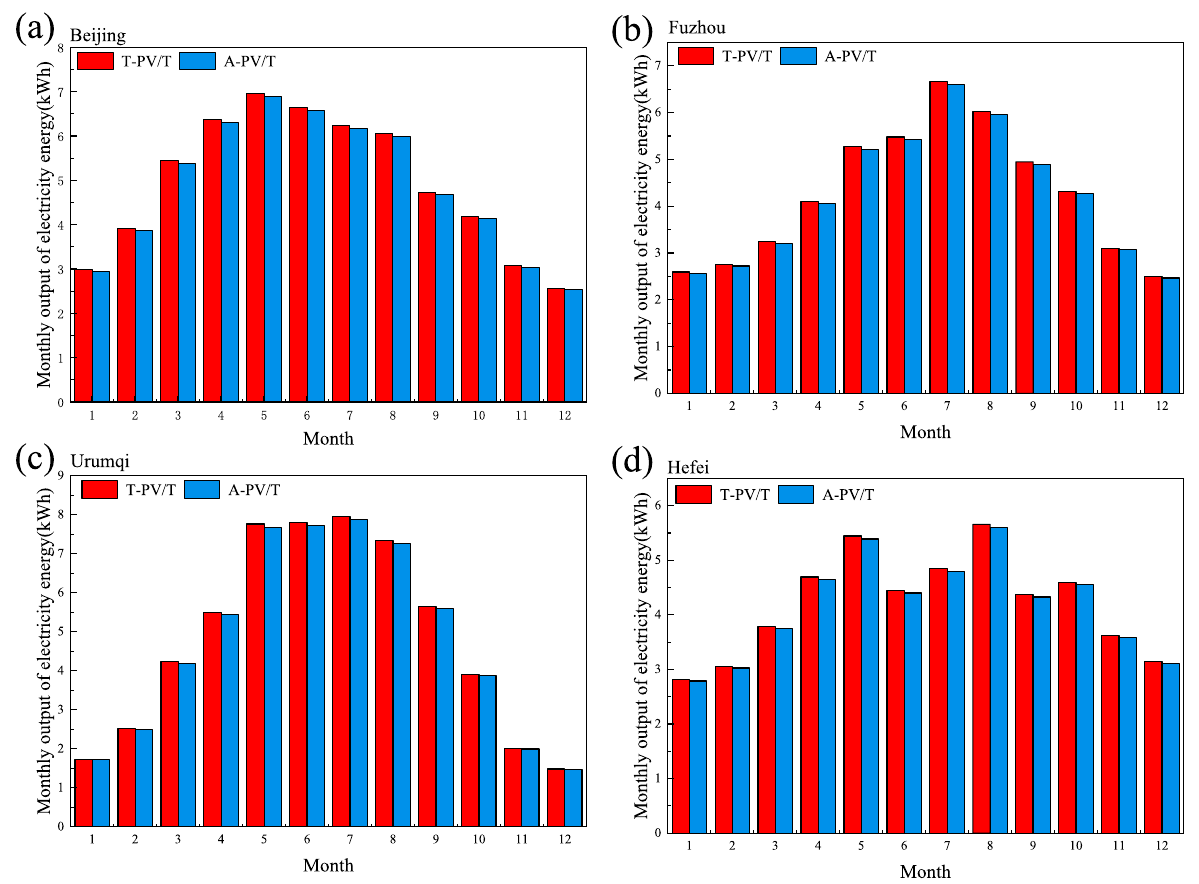
Fig. 15 Monthly output of electricity in a Beijing, b Fuzhou, c Urumqi, and d Hefei